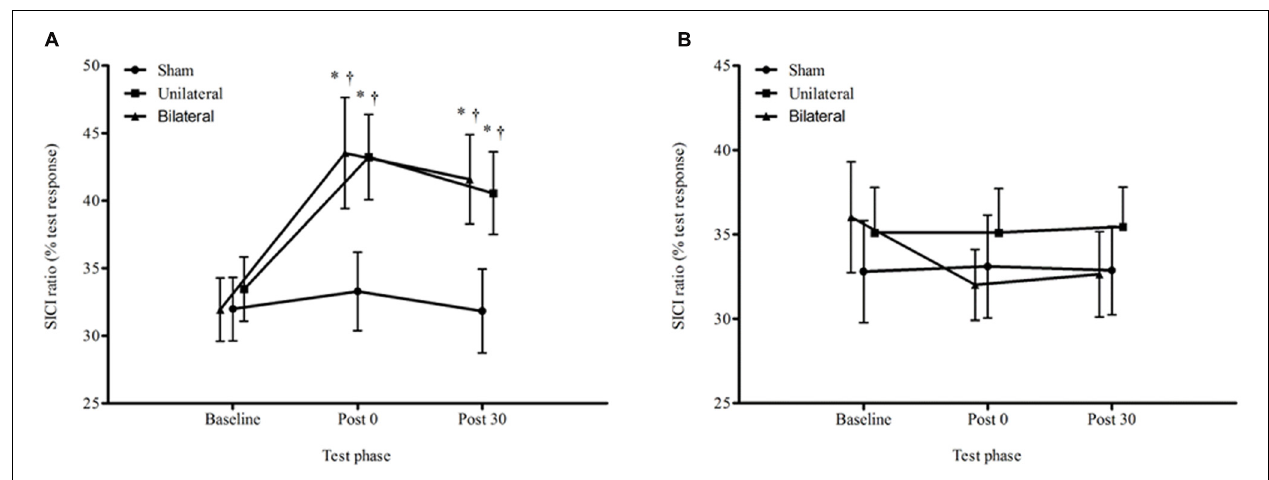
FIGURE 5 |Average ± SEM SICI ratios (% of the test response) for all conditions across all time points . (A) non dominant M1, (B) dominant M1. ∗ p < 0.05 compared to baseline. † p < 0.05 compared with sham.